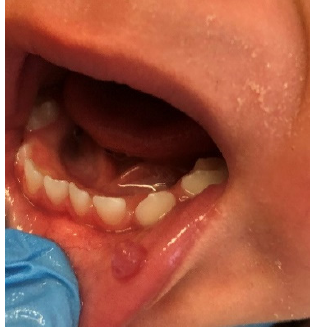
Figure 7. Fibroma on the lower lip of a female infant. A fibroma is a smooth, pink, dense nodule that arises in a chronically irritated area. The lesion has a broad peduncle and is painless and non- bleeding.